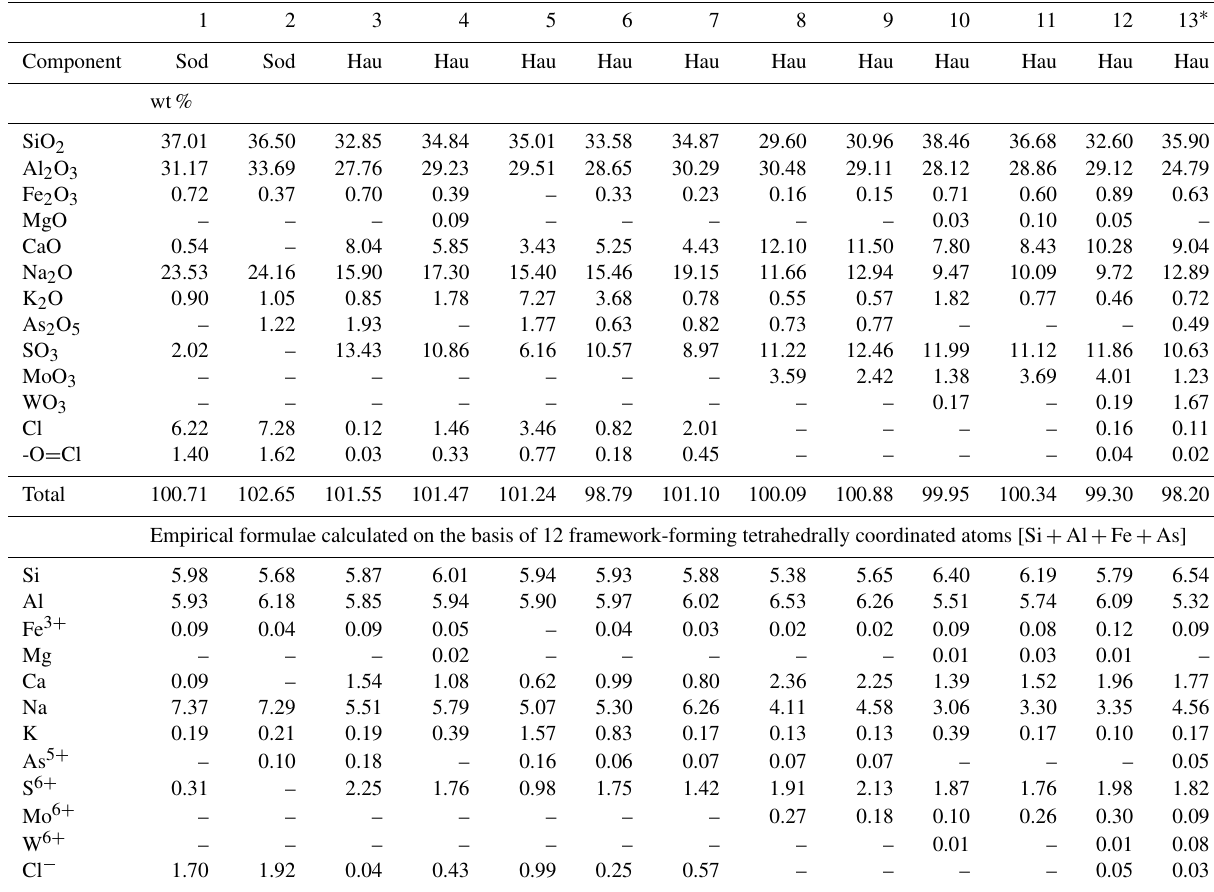
Table 5. Chemical composition of sodalite (Sod) and hauyne (Hau) from the Arsenatnaya